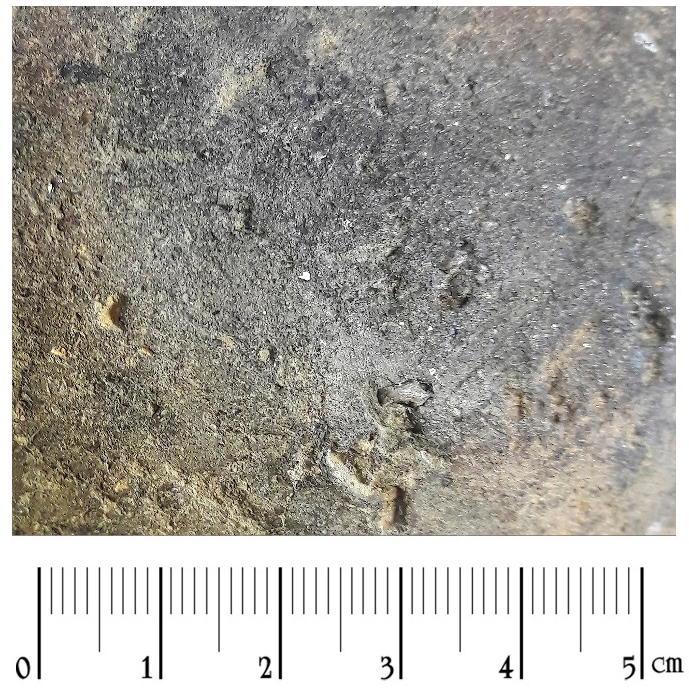
Figure 2. Detail of external surface and its tonality.